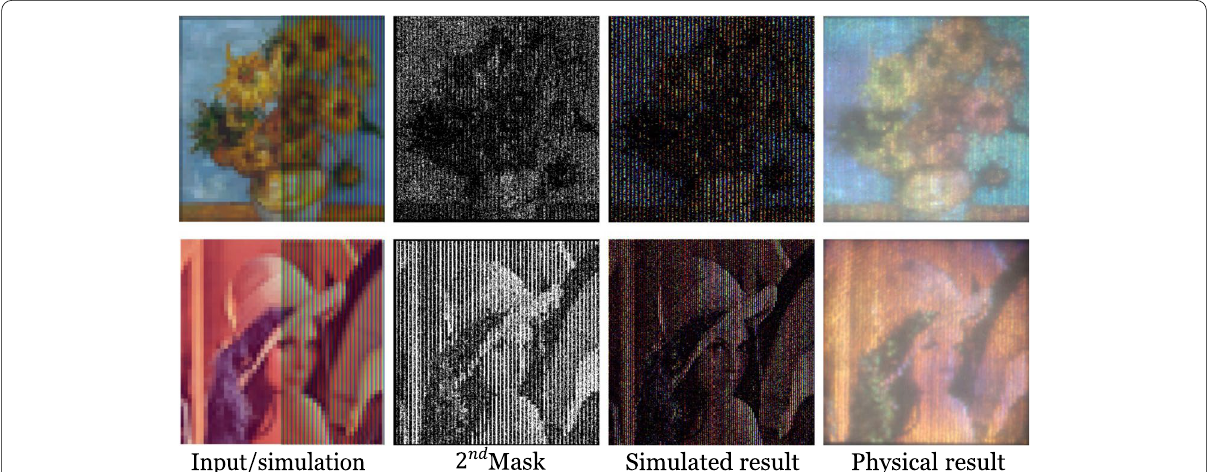
Fig. 26 Two experiments of Hostettler et al. [68]. From left to right are comparisons of the input image and the simulated result, the second mask, the simulated result, and the fabricated result